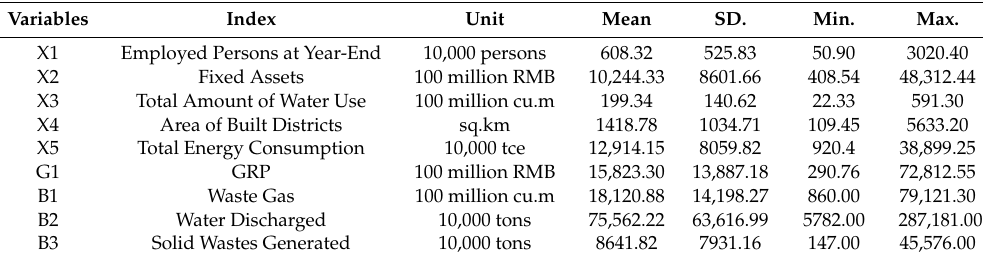
Table 1. Descriptive statistical data from 2006 to